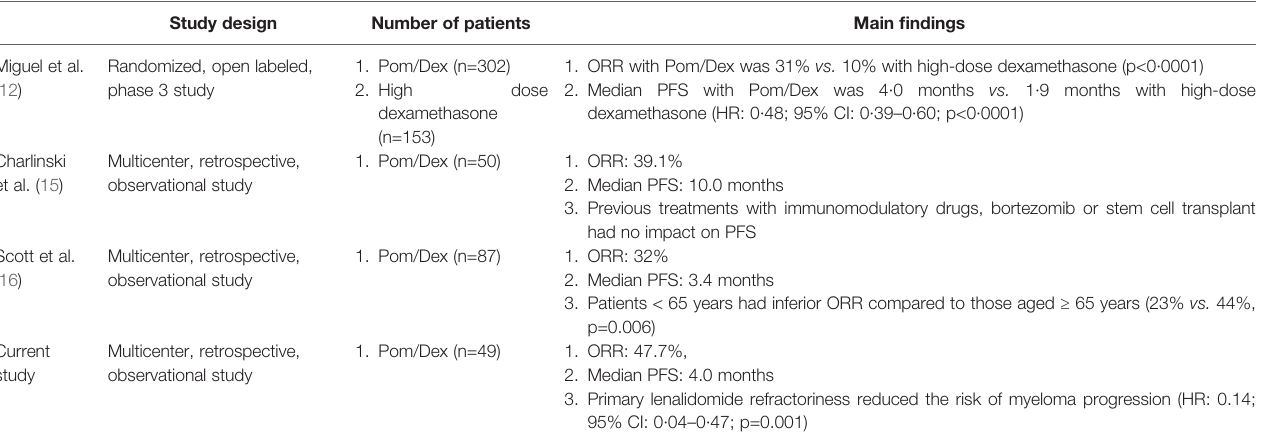
TABLE 5 | Clinical studies of Pom/Dex in relapsed or refractory multiple myeloma. Study